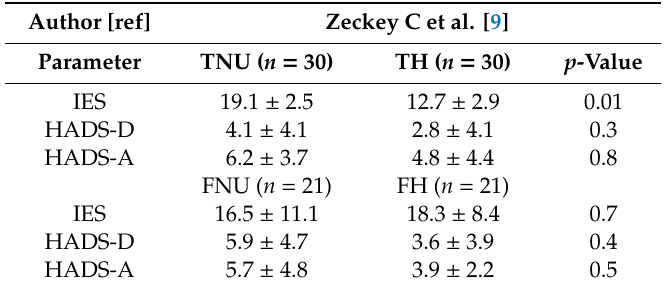
Table 6. The impact of tibial and femoral non unions on the development on anxiety and